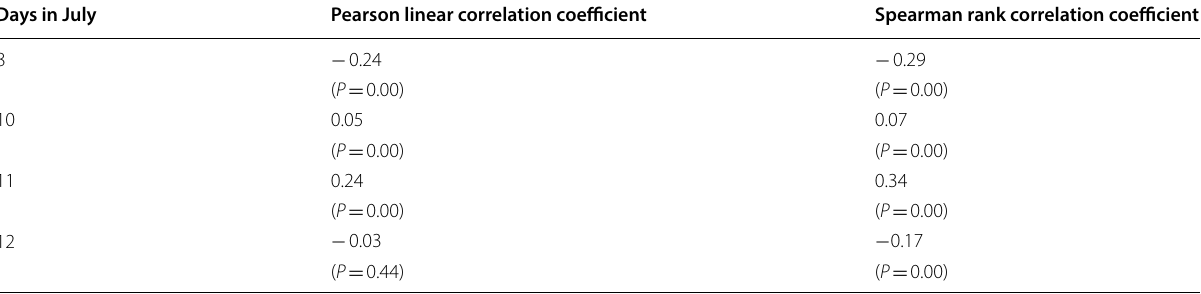
Table 3 Correlation coefficients computed for all the combined data points having simultaneous occurrence of PMSE and particle precipitation in each